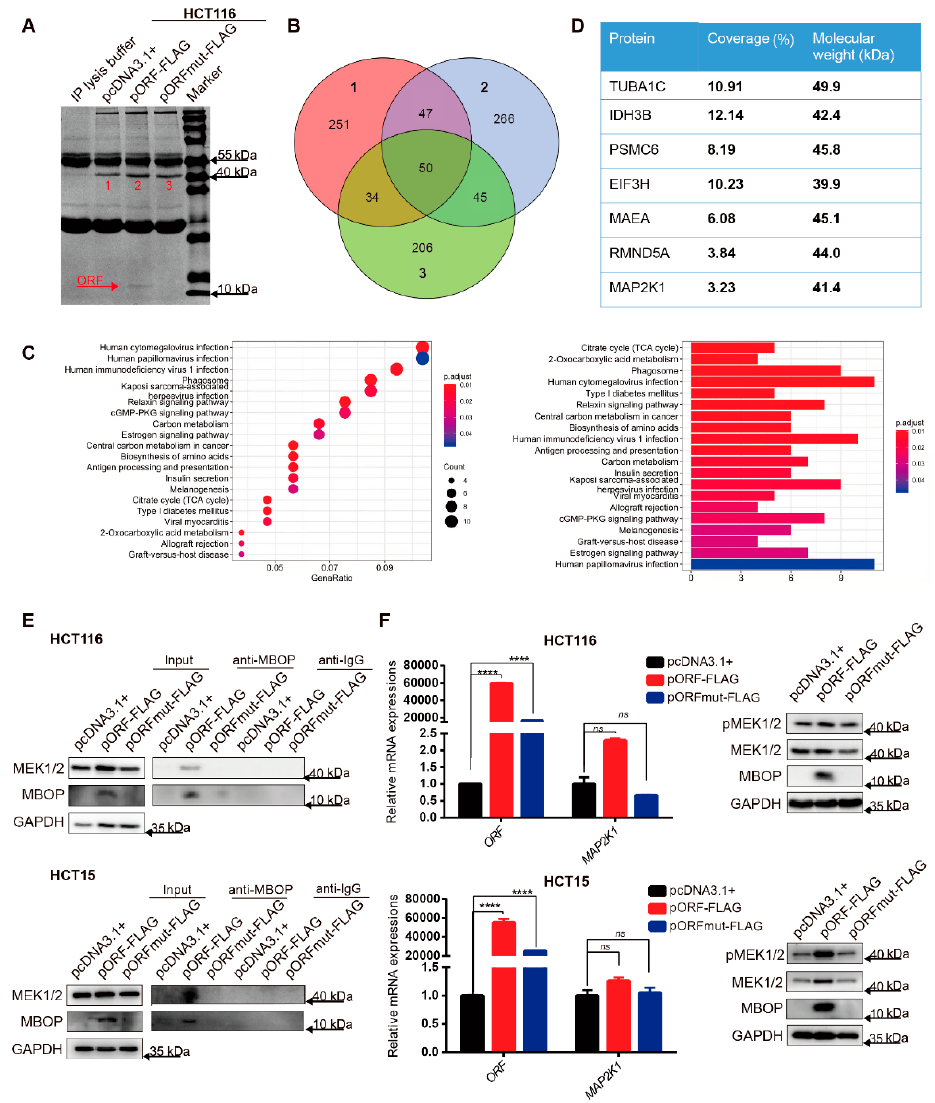
Figure 4. MBOP interacts with MEK1 in CRC. ( A ) Immunoprecipitation (IP) followed by mass spectrometry assay identified the interacting proteins of MBOP. ( B ) Venn diagram where 1 refers to pcDNA3.1+, 2 refers to pORF-FLAG, and 3 refers to pORFm-FLAG, delineated the range of potential interacting proteins—in total 266 candidate proteins. ( C ) KEGG analysis of the above-mentioned 266 proteins, and viral-infection relevant pathways ranked the top among all the pathways. ( D ) Sequential coverage and molecular weight of some candidate interacting proteins. ( E ) After overexpressing pcDNA3.1+, pORF-FLAG, and pORFmut-FLAG in HCT116 and HCT15, the direct interaction between MBOP and MEK1 was proved. ( F ) MBOP did not significantly alter the mRNA expression of MAP2K1 , but substantially promoted the protein level of total MEK1 (pMEK1 included). Data are presented as mean ± SD, **** p < 0.0001. ns: not